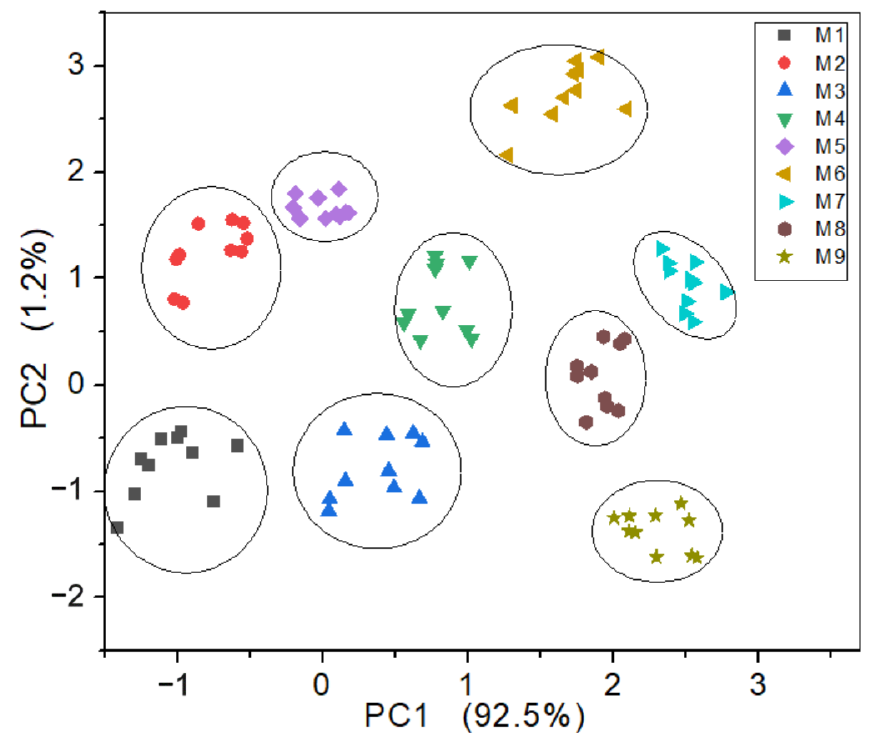
Figure 12. PCA analysis of gas features extracted by the E-nose with the sensor array optimized based on EWM-TOPSIS model.